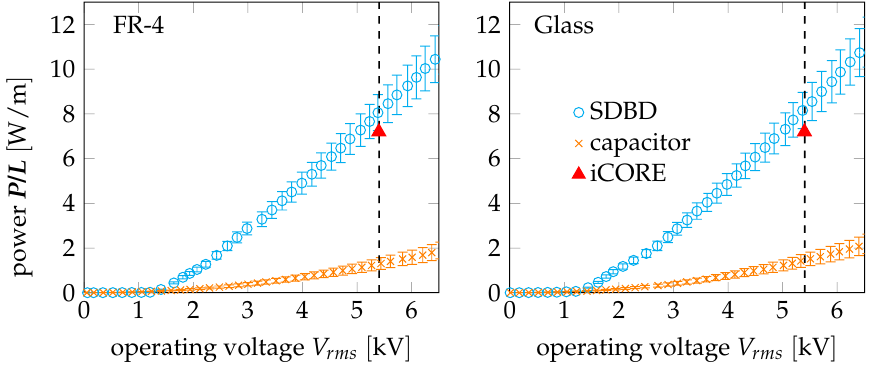
Figure 7. The consumed power for the glass and the FR-4 SDBDs measured for different operation